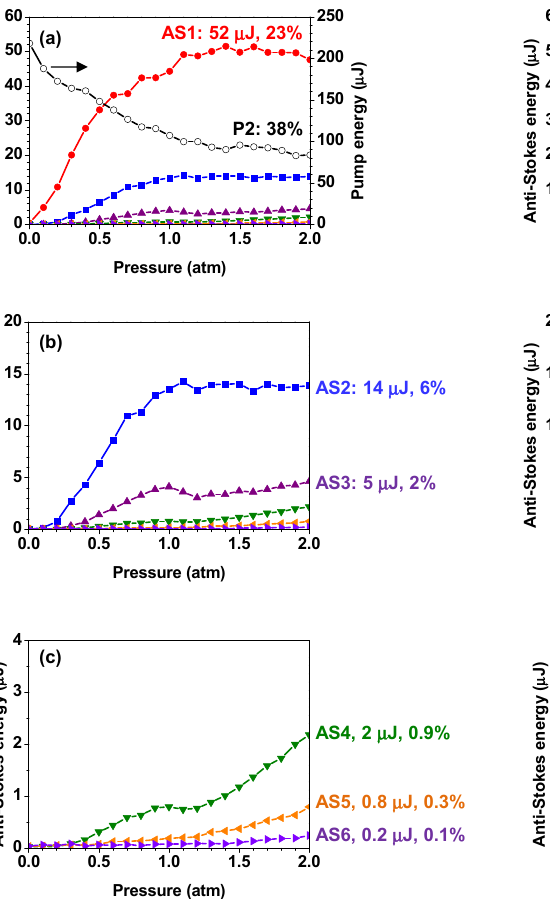
Figure 6. Spectra of the output beam from the gas cell (red solid line) and the hollow fiber (black solid line) measured at a pressure of 2 atm. The energies of the input pump pulses for the gas cell are lower than those for the hollow